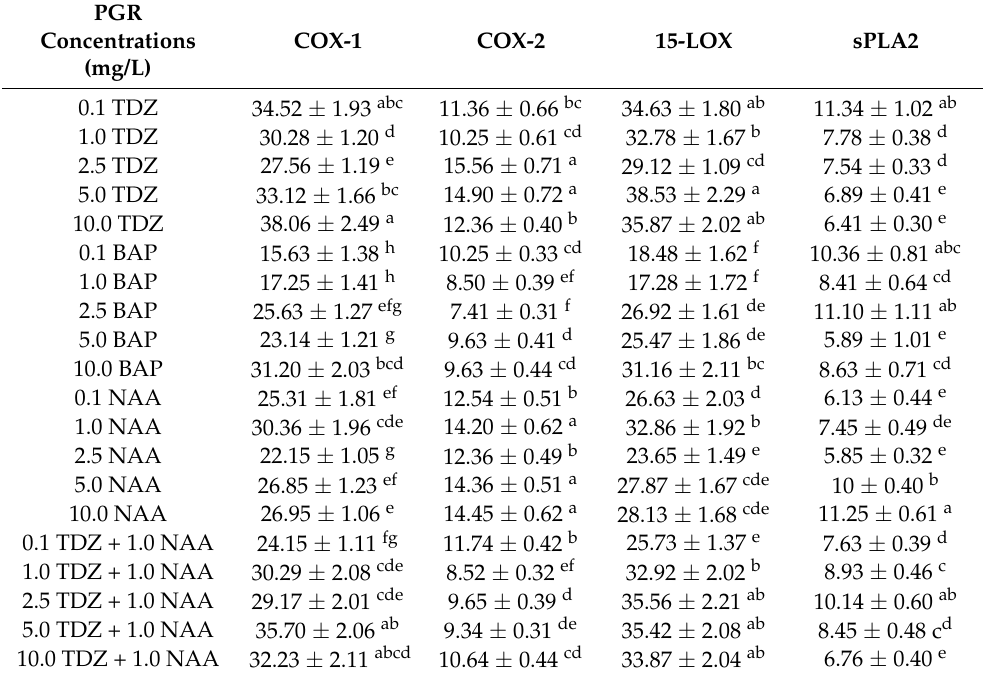
Table 6. Potential in vitro anti-inflammatory activities (expressed in % of inhibition) of the extracts of callus cultures of S. virginianum treated with different plant growth